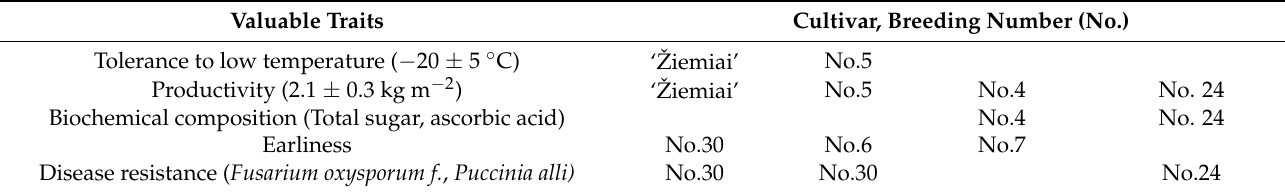
Table 7. Parental material from garlic national and adapted genetic